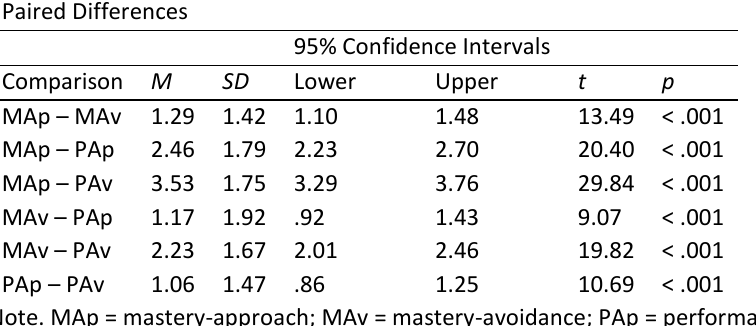
Table 2. Results for paired t -tests amongst the 2 × 2 achievement goals Paired Differences 95% Confidence Intervals